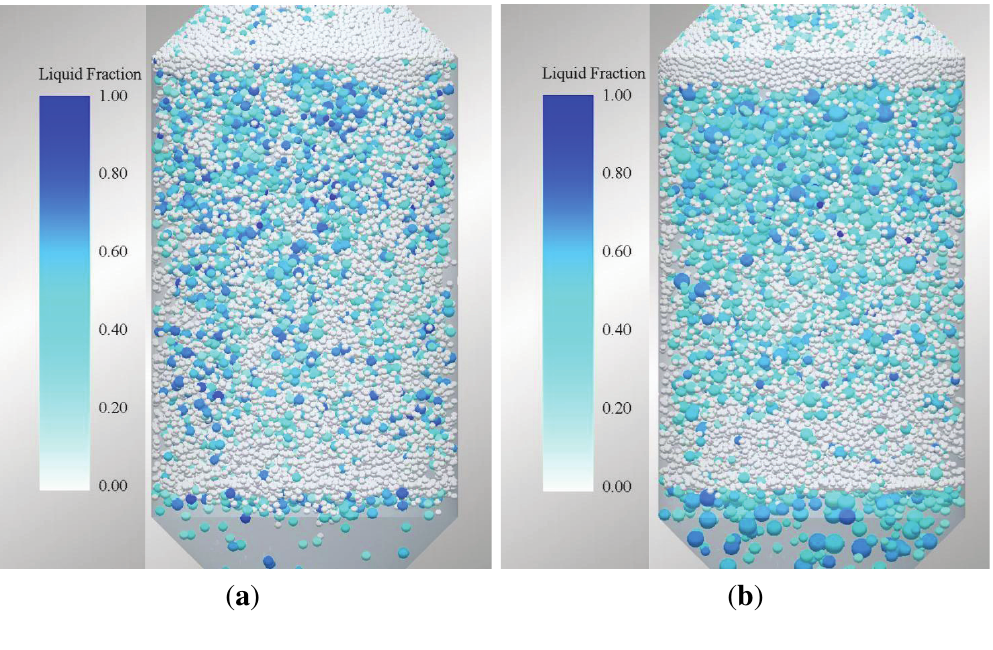
Figure 5. EDEM TM snapshots of liquid content. ( a ) Particle liquid content at time = 1 s; ( b ) Particle liquid content at time = 2 s.